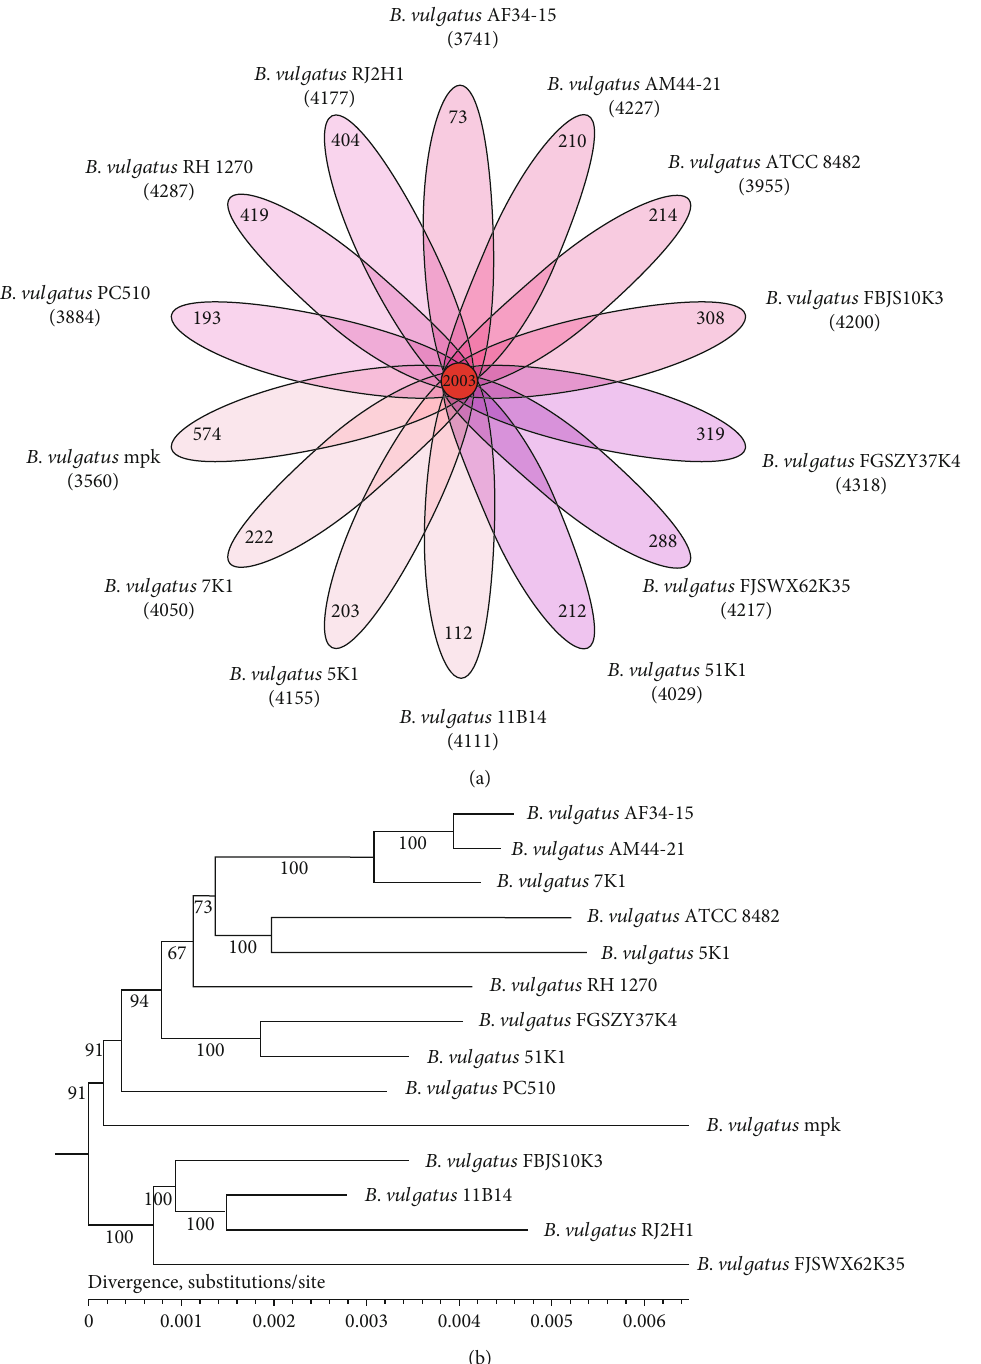
Figure 1: Core genes and phylogenetic analyses of 14 Bacteroides vulgatus strains. (a) Venn diagram of homologous clusters shared among the core genes. (b) Phylogenetic tree of 14 strains of B. vulgatus . Bootstrap con fi dence values were marked in the phylogenetic